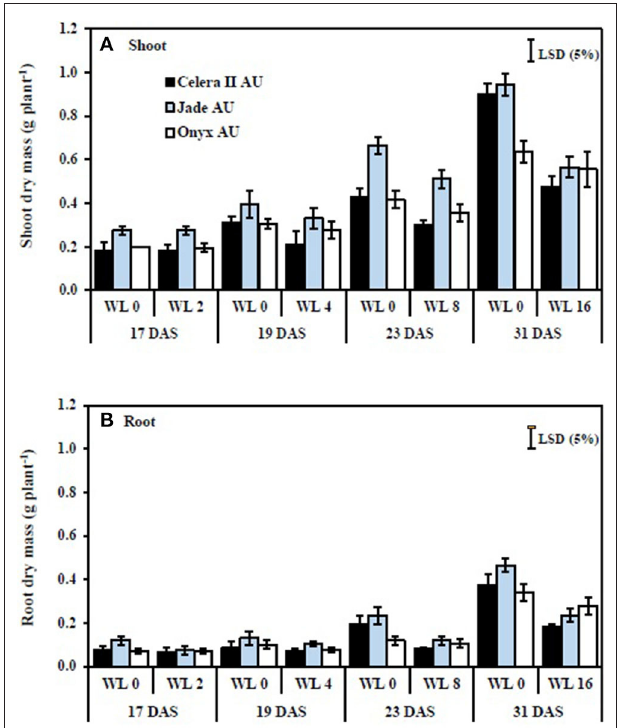
FIGURE 4 | The effect of different waterlogging durations on the shoot (A) and root (B) dry mass of three genotypes grown in soil: WL0, drained control; WL2, WL for 2 days, harvested at 17 days after sowing (DAS); WL4, WL for 4 days, harvested at 19 DAS; WL8, WL for 8 days, harvested at 23 DAS; WL16, WL for 16 days, harvested at 31 DAS. Treatments were imposed at 15 DAS. Bars are means ( n = 4) ± SE and least significant differences (LSD) at P = 0.05 for